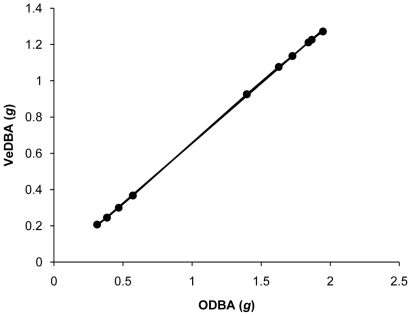
Relationship between mean ODBA and mean VeDBA (means taken for each running speed) for a test participant during a  max test.Only data during the period when the participant did not exceed the ventilatory threshold (for definition see text) are included. as with all other participants, the relationship between ODBA and VeDBA was highly significant (VeDBA = 0.014+0.6418 ODBA, r2 = 0.987, P<0.001).